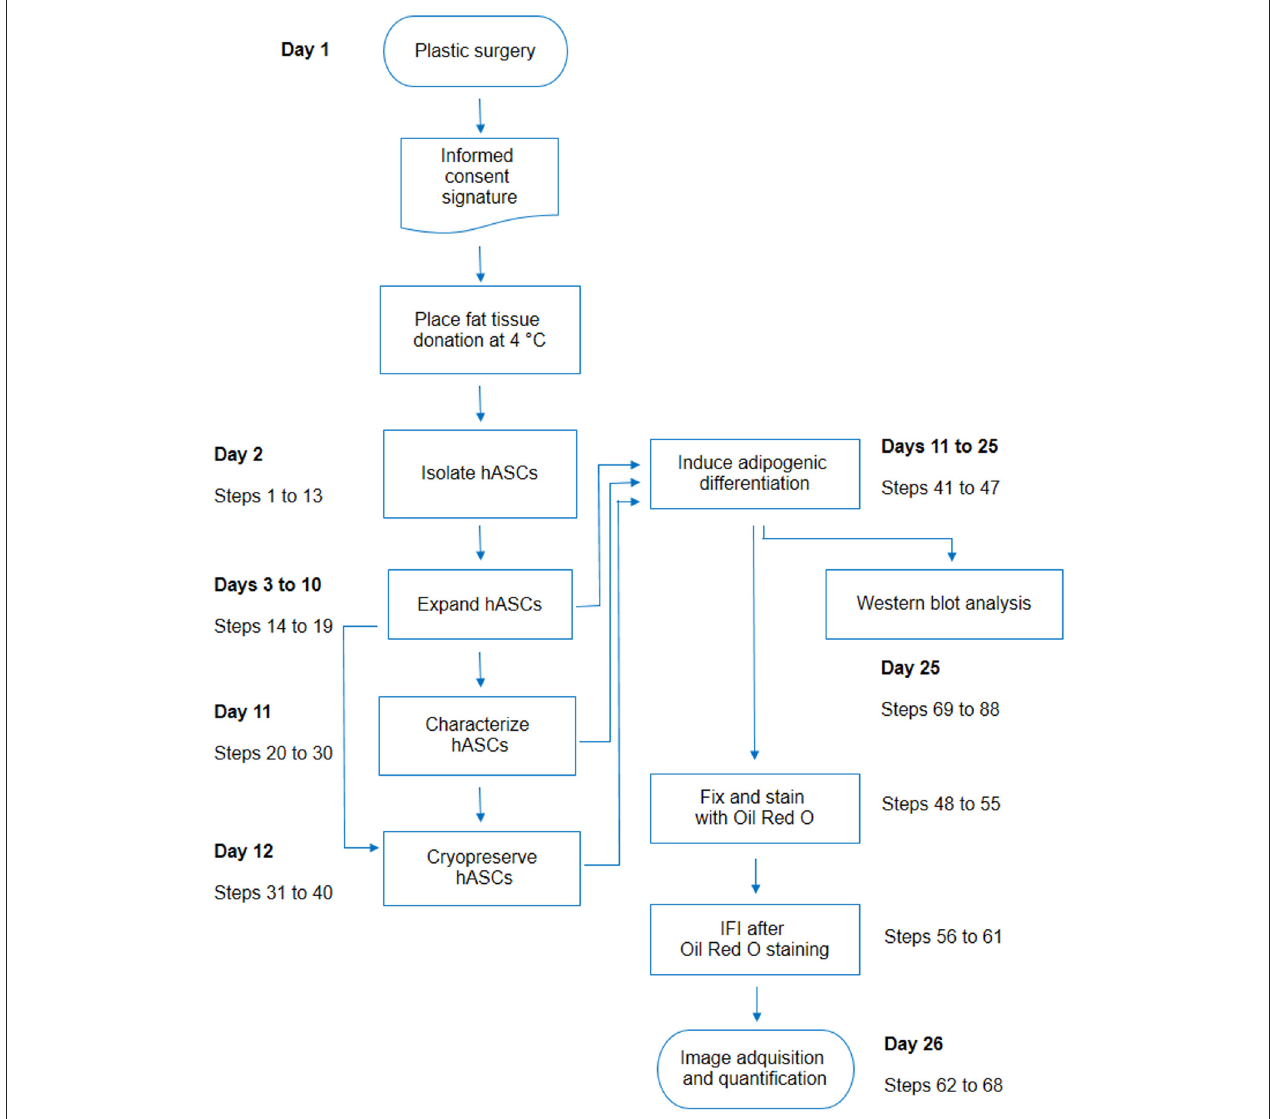
FIGURE 6 | Flow chart including all steps described in this protocol. For each activity detailed in the protocol, the corresponding step numbers were indicated on the side, with an estimation of the earliest day after the plastic surgery in which the activity may be